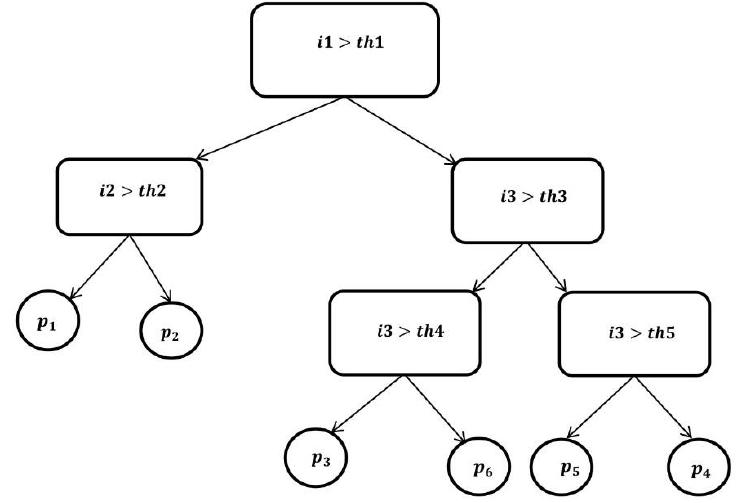
Figure 3. Schema of structure of a regression decision